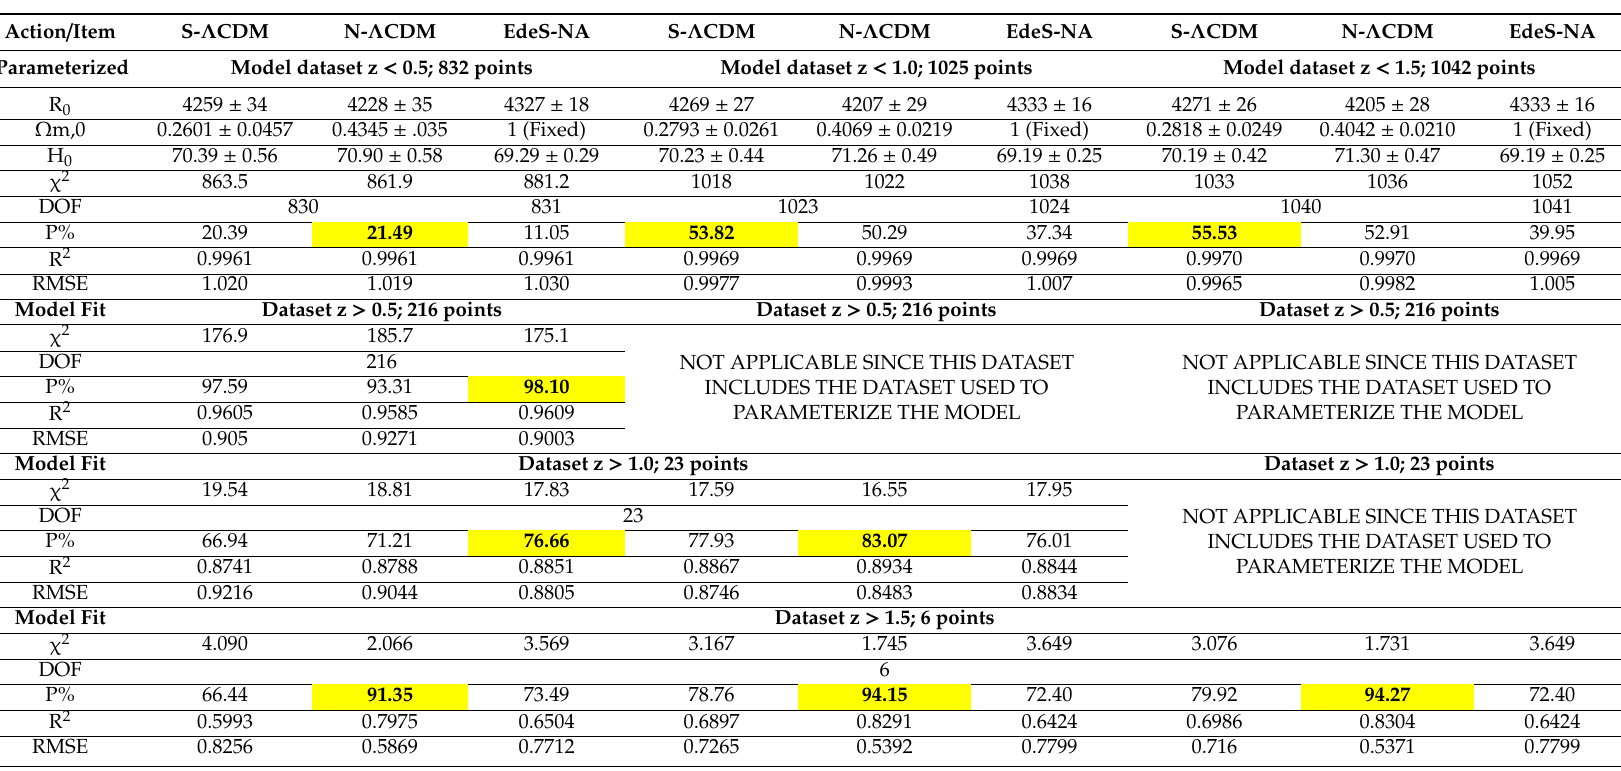
Table 1. Parameterizing and prediction table for 3 models. This table shows how well a model is able to fit the data that is not used to determine the model parameters. The unit of R 0 is Mpc and of H 0 is km s − 1 Mpc − 1 . P % is the χ 2 probability in percent that is used to assess the best model for each category; higher the χ 2 probability P better is the model fit to the data. R 2 is the square of the correlation between the response values and the predicted response values. RMSE is the root mean square error. Highest P % value in each category is shown in bold and the cell